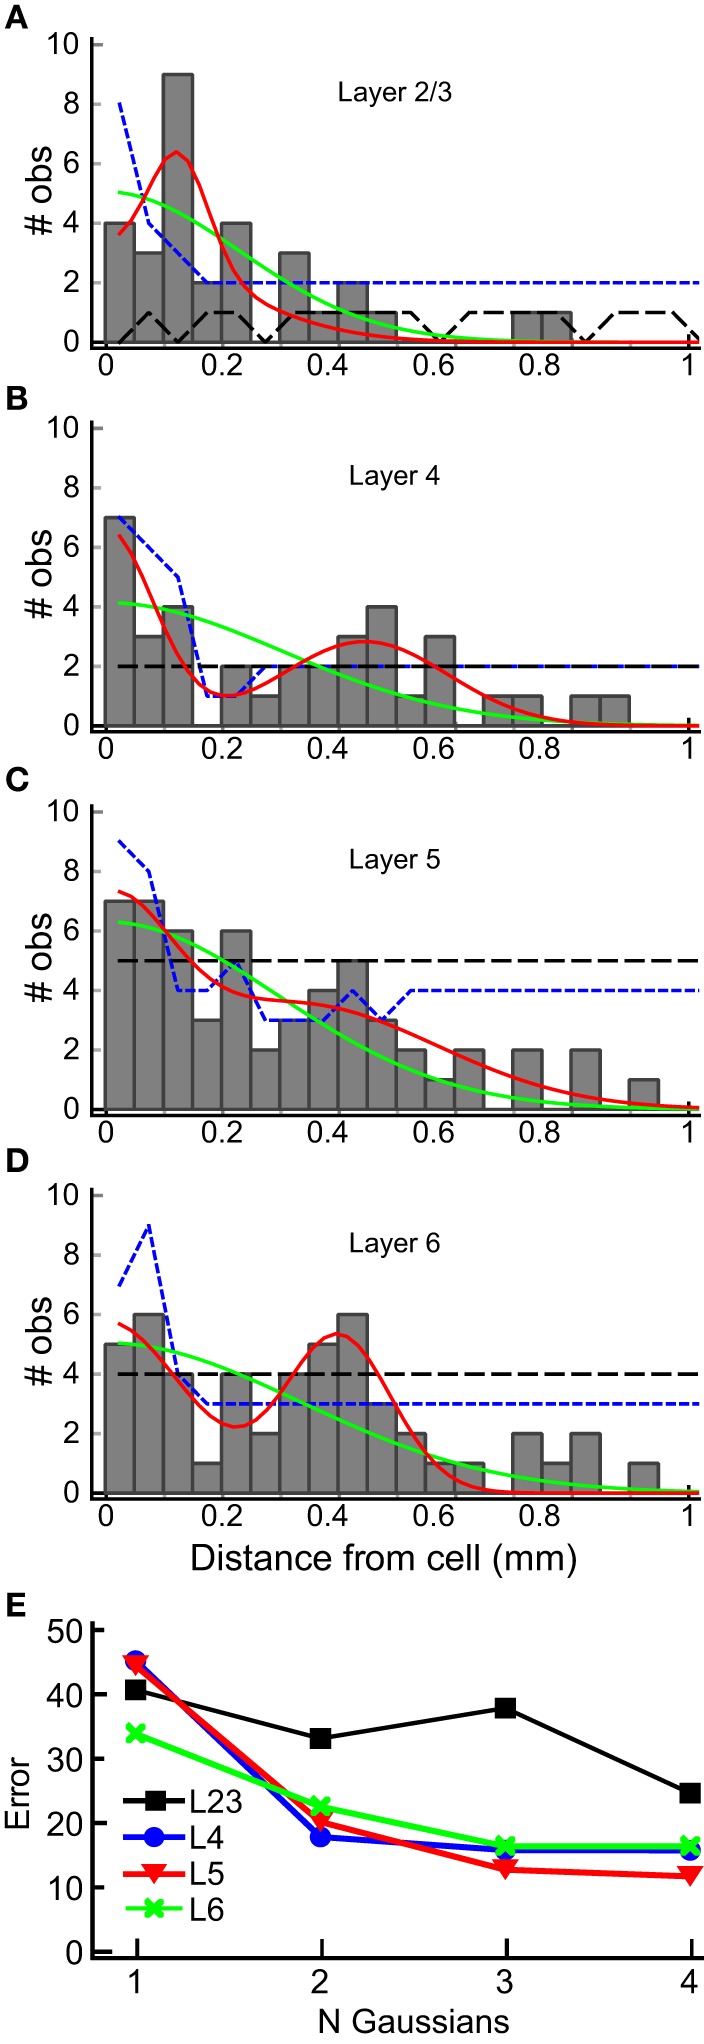
Horizontal distribution of input sites, by layer. The numbers of observations of center-of-mass positions computed as in Figure 7 are plotted as a function of the absolute distance from the cell body, in 50 μm bins, for each layer (gray bars) for each layer (A–D). The histograms summarize combined results from all 22 L4 cells. Solid lines are superimposed plots of fits of the distribution to a single Gaussian (center position 0 μm; green line) and to the sum of two Gaussians (one with center position at 0 μm, the other position was allowed to vary). The 95% one-sided confidence interval computed by shuffling positions (5000 trials) under the assumption that the probability of a central input straddling 0 μm was the same as observed in the data set (see Results) is shown as the short dashed blue line. The 95% one-sided confidence interval computed using all input positions, and not requiring a central peak that straddles 0 μm, is shown as the long dashed black line. Note that the histogram equals or exceeds the 95% confidence interval for bins more than 250 μm away from the cell at 200, 300 and 450 μm in L2/3 (A), 300 to 600 μm in L4, with the exception of 250 and 550 μm (B), 200 and 450 μm in L5 (C), and 200 to 450 μm, with the exception of 250 μm, in L6 (D), with at least one bin falling below the 95% CI for closer distances in all cases. In L2/3, the data exceeds the 95% CI for most bins for the uniform distribution, and for intervals > 250 μm only for 300–400 μm. (E) Summary of error of the Gaussian fits for 1–4 Gaussians to the histograms in (A–D) (plots for 3 and 4 Gaussians are not shown in A–D for clarity). A major decrease in the fit error is seen between 1 and 2 Gaussians in L4, L5, and L6. There is little improvement with additional Gaussian terms. A lesser improvement in seen for more than 1 Gaussian in L2/3.